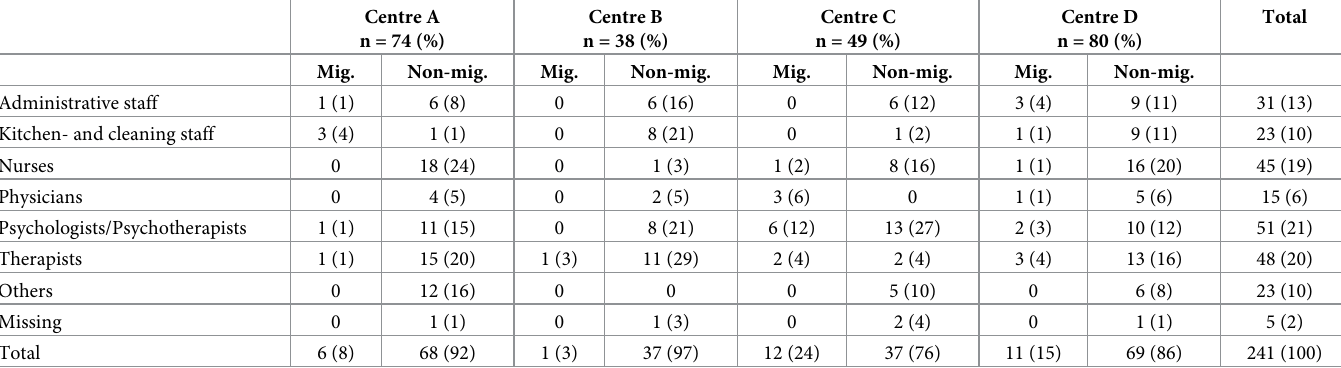
Table 2. Migrant and non-migrant workers stratified by centre and professional group.